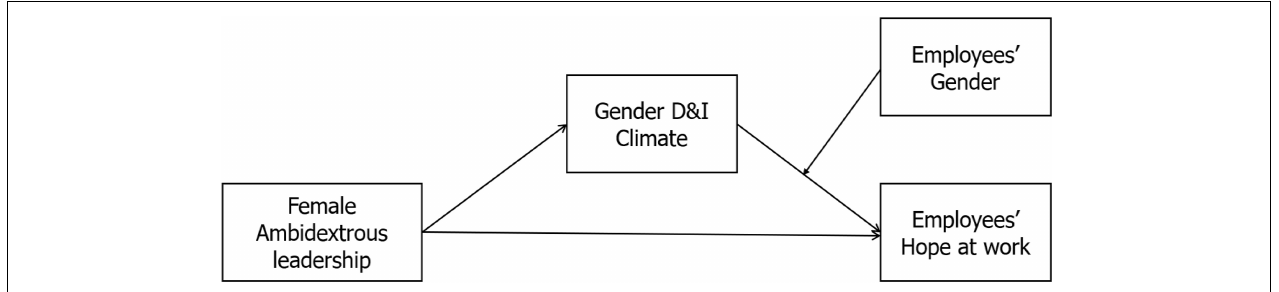
FIGURE 1 | Hypothesized research